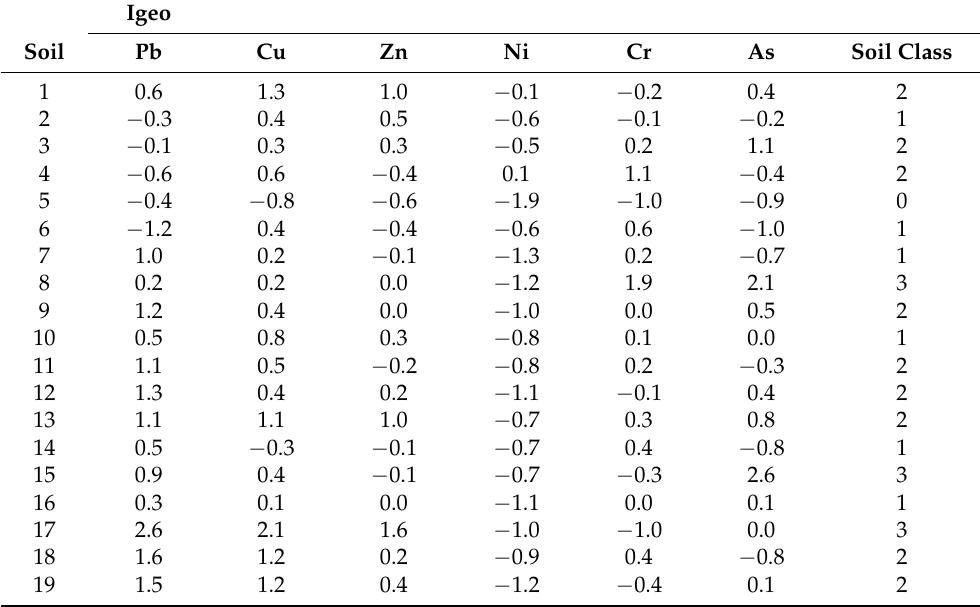
Table 5. Values of the geoaccumulation index